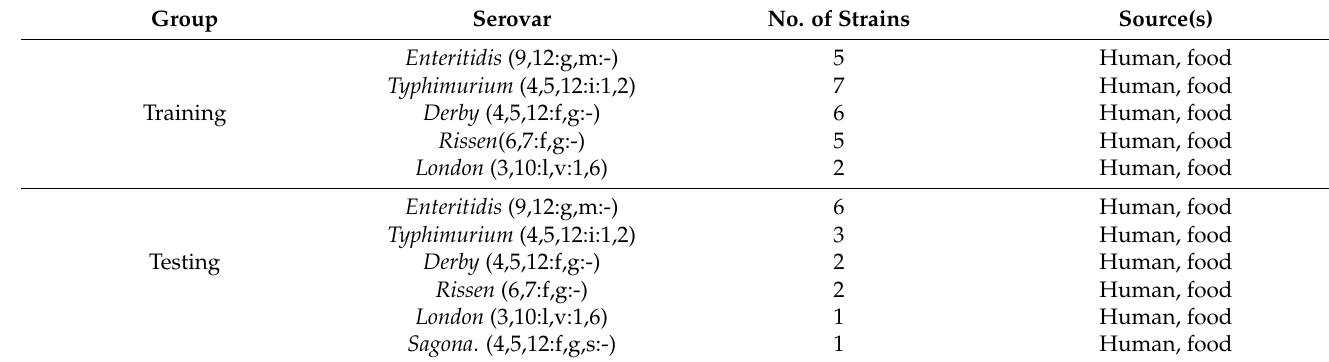
Table 1. Salmonella enterica subsp. enterica strains ( n = 40) used in this